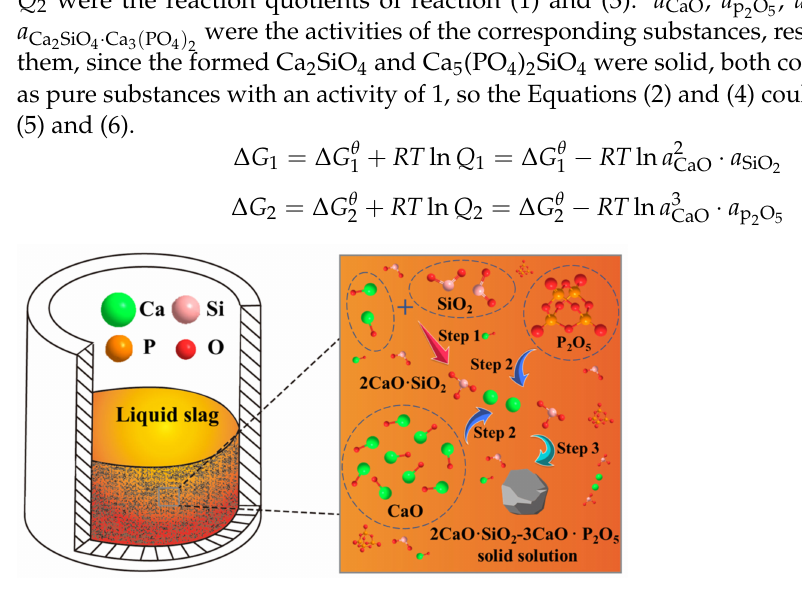
Figure 6. Formation mechanism diagram of Ca 5 (PO 4 ) 2 SiO 4